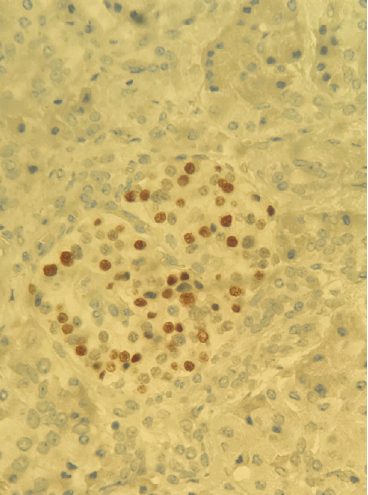
Figure 7: Immunohistochemical staining shows positive nuclear positivity for progesterone